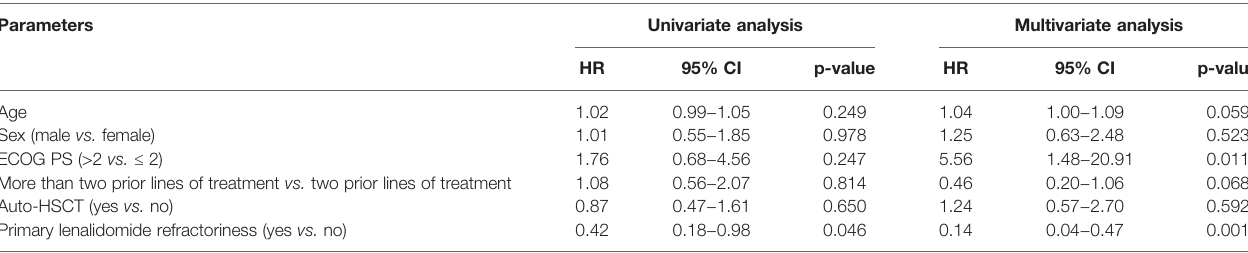
TABLE 3 | Factors associated with progression following